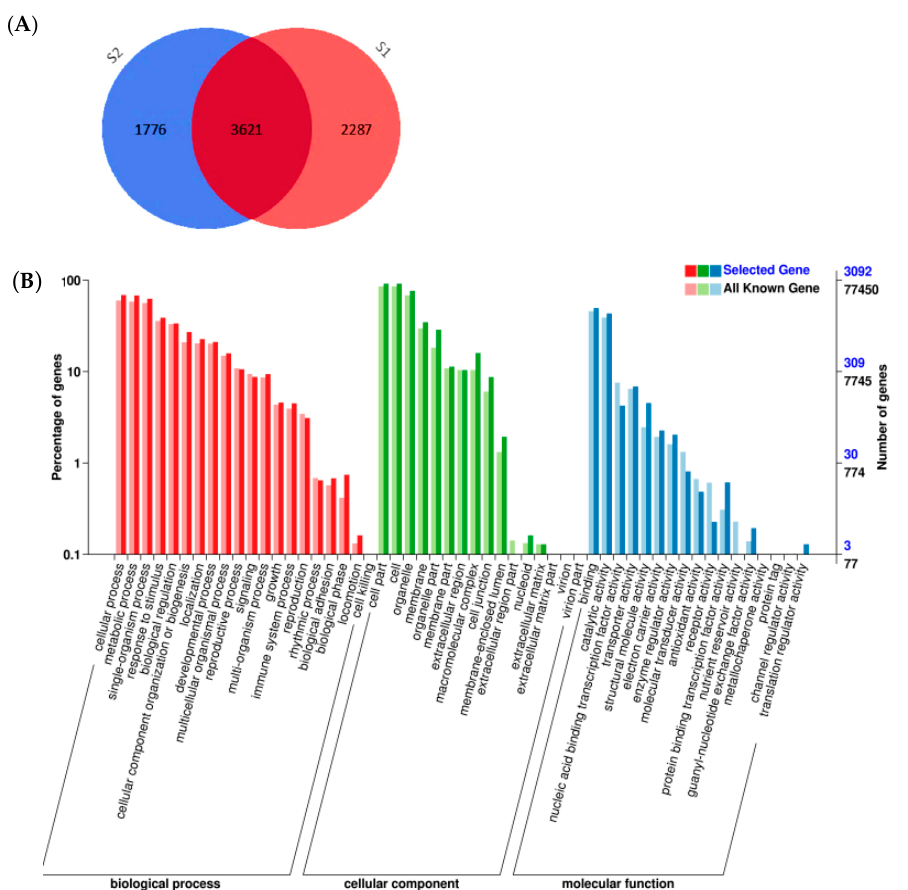
Figure 2. Number and functional classification of differentially expressed genes (DEGs). ( A ) The number of DEGs detected between 6098B and Purler at bolting (blue), early flowering (light pink), and both (dark pink) developmental stages. ( B ) Functional classification of DEGs identified at both development stages by Gene Ontology (GO) categorization. Bold colours indicate the representation in the whole genome, the light colours indicate representation in the